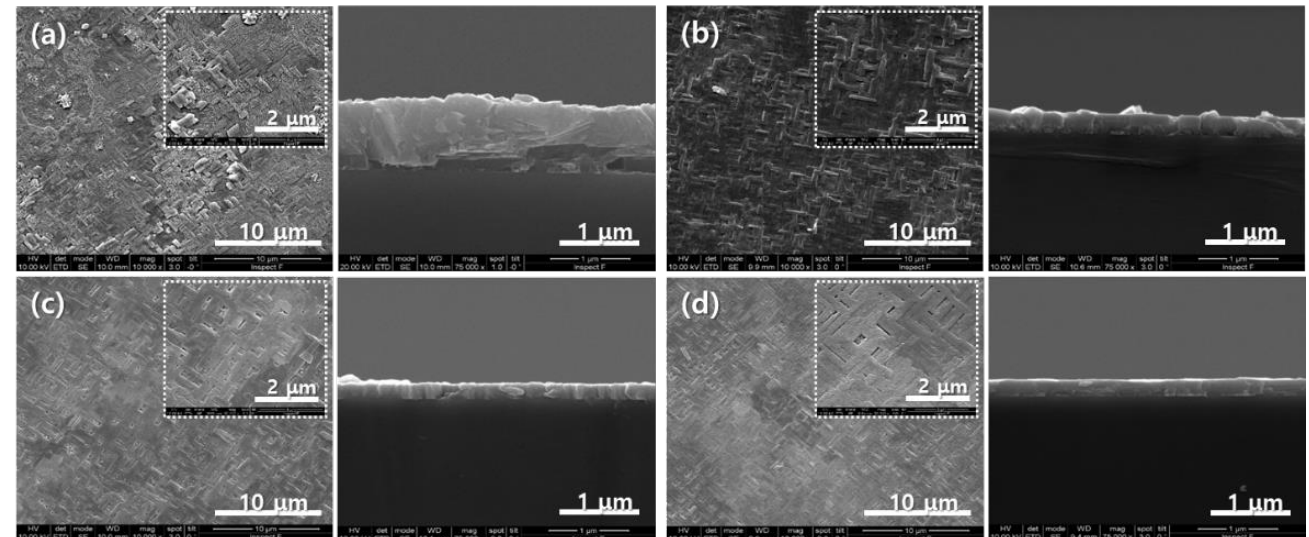
Figure 4. Surface morphologies and cross-sectional images of KTN thin films deposited on LaAlO 3 substrate for 3 h as a function of RF power applied to targets. The growth rates were obtained from cross-sectional images: ( a ) KTN-01, 5.56 nm/min ( b ) KTN-02, 1.53 nm/min ( c ) KTN-03, 1.17 nm/min, and ( d ) KTN-04, 1.17 nm/min.